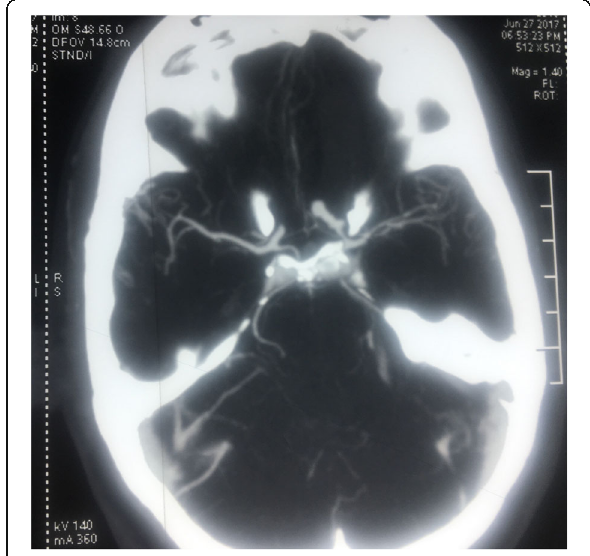
Fig. 2 CT angiography anteroposterior view showing superior hypophyseal artery aneurysm projecting medial to the anterior clinoid